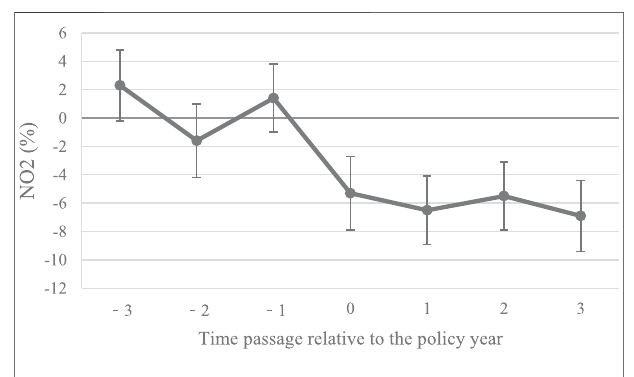
FIGURE 8 | The parallel trend test for the NO 2 .